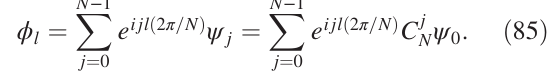
FIG. 16. Illustration of the dimensional reduction procedure for TCIs protected by sixfold rotation symmetry. The 2D plane is divided into six symmetry-related regions separated by three lines at angle π = 3 from each other. The three lines form a 1D symmetry-invariant region for which the construction can be repeated to reduce the problem to the 0D problem with internal Z symmetry at the rotation N